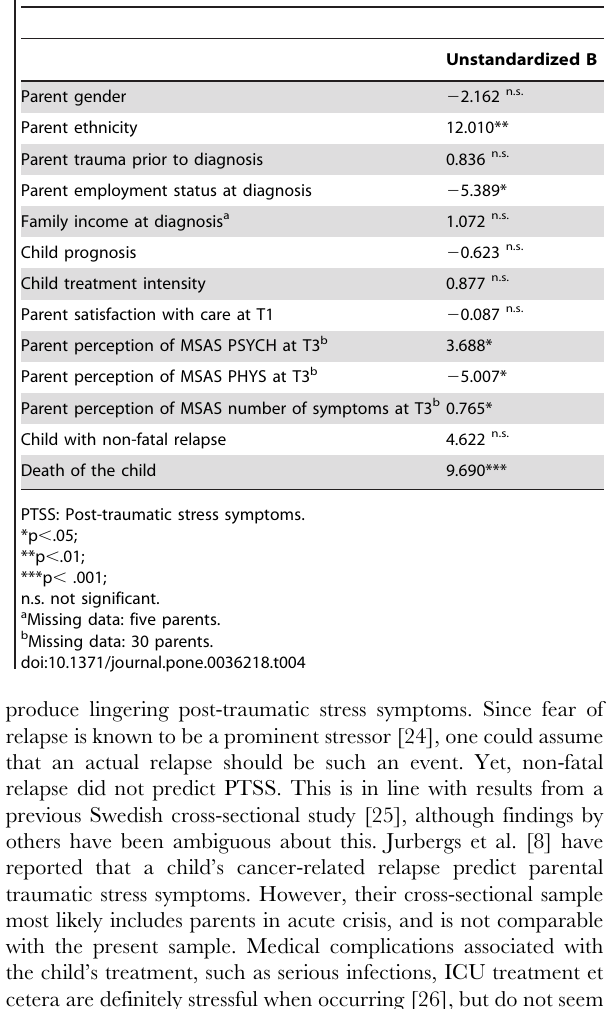
Table 4. Associations between potential predictors and parental PTSS 12 months after completed treatment or death, or 18 months after transplant (Hierarchical multivariate model;